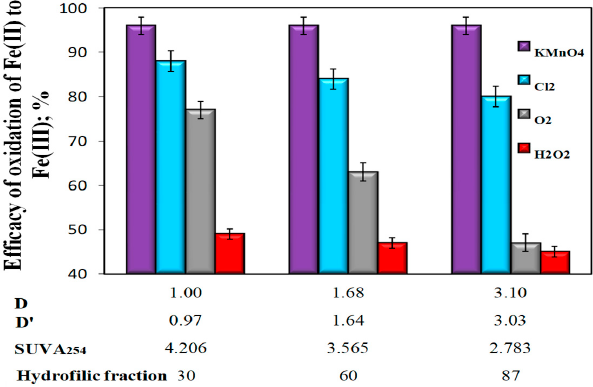
Figure 3. The impact of the type of oxidant and values of the co-occurrence coefficient of organic substances and total iron (D and D’), SUVA 254 coefficient, and hydrophilic organic content (%) on the oxidation efficiency of Fe(II) to Fe(III).